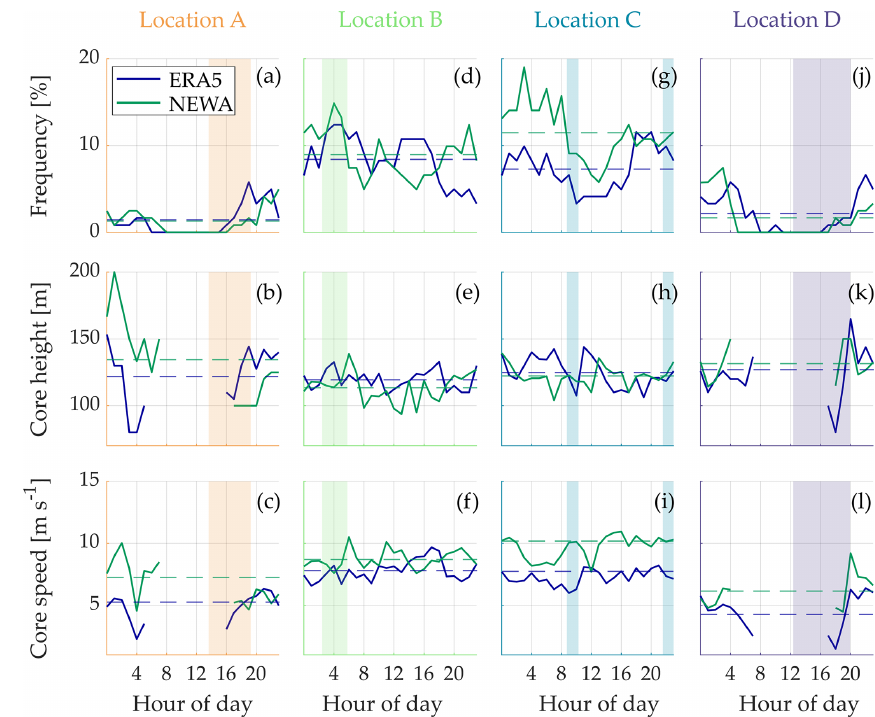
Figure 9. Frequency, core height, and core speed daily cycles at the selected four locations based on ERA5 and NEWA. The shadowed areas indicate the time intervals when the vessel is close (within 10km distance) to the corresponding location. Dashed lines are the mean values. Table 3. Mean values of main low-level jets characteristics according to ERA5 and NEWA. Wind profiles up to 300m and only data from those hours where the ship is in this location (within 10km distance) are used (corresponding to shadow areas in Fig. 9.) Location